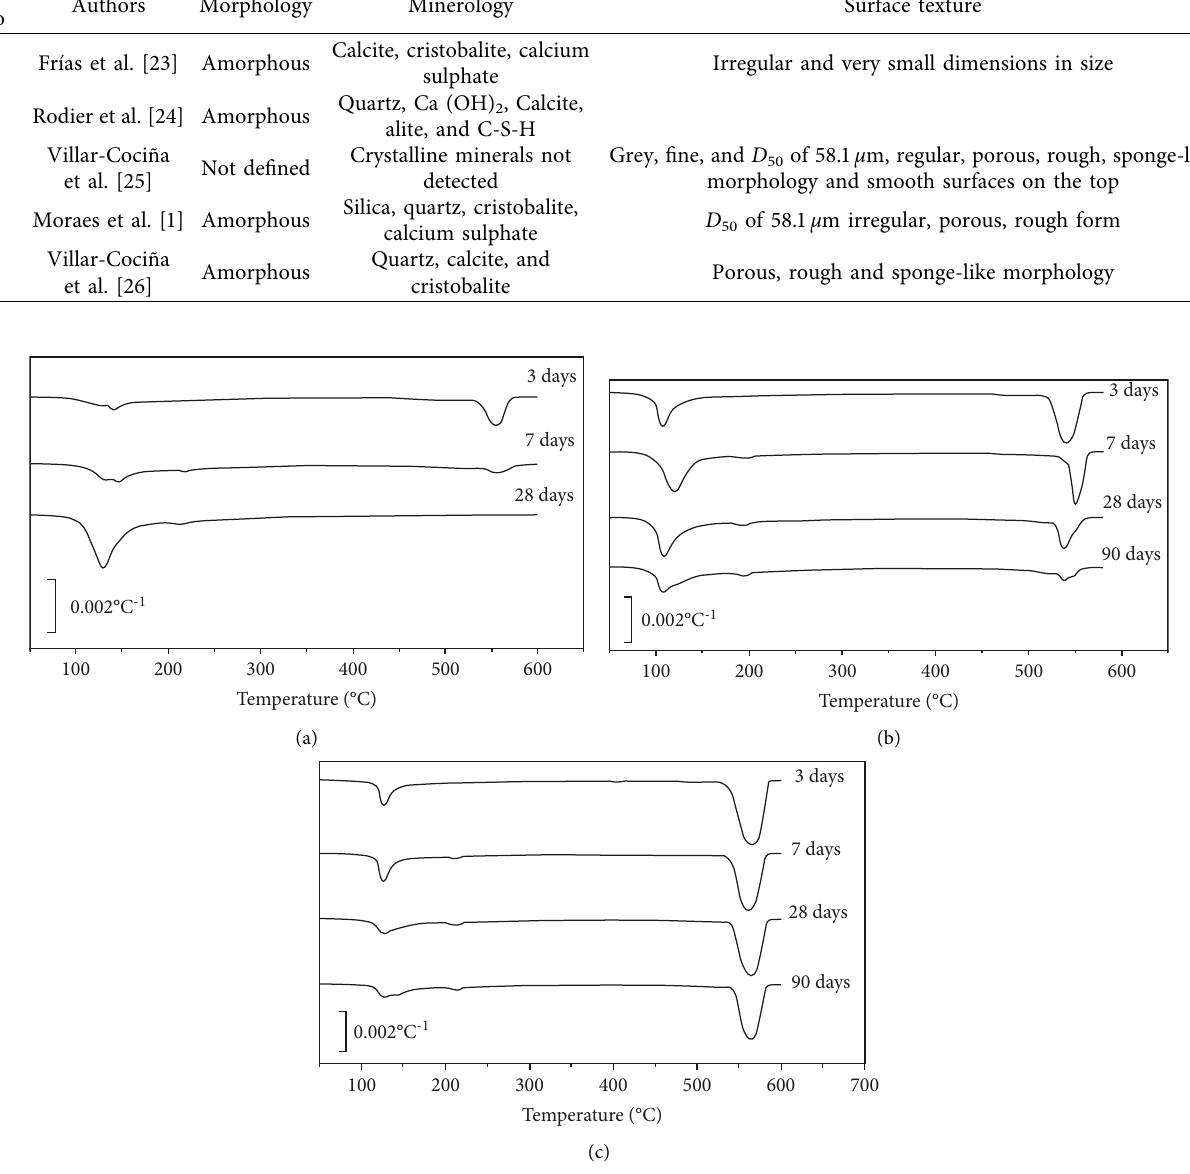
Figure 5: DTG curves for pastes of CH/BLA ratio of (a) 3 :7, (b) 5 :5, and (c) 7: 3